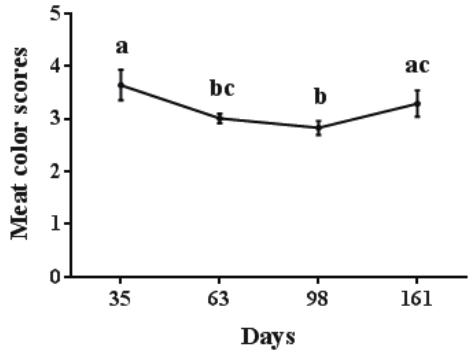
Figure 1. Changes of meat color scores in longissimus dorsi at different stages of growth. Mean with different superscripts demonstrate significant difference among groups (p<0.05), n =